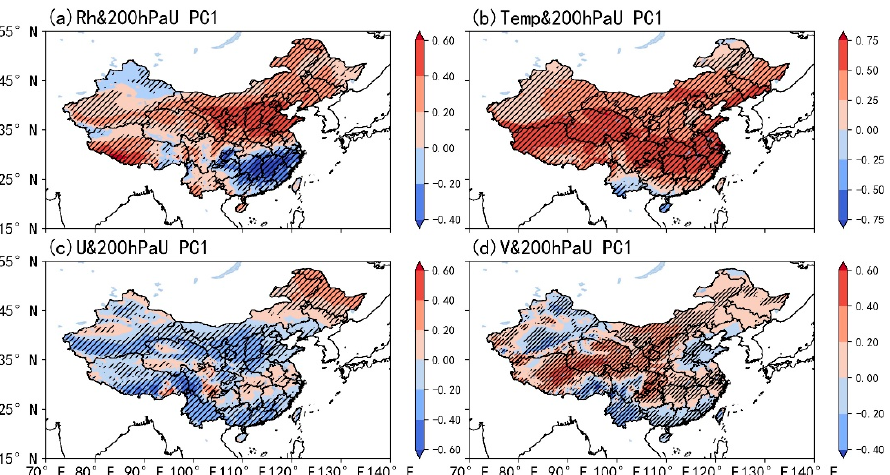
Figure 12. The correlation coefficients between the time series of the EOF1 of the 200 hPa zonal wind and surface meteorological variables of the ( a ) humidity, ( b ) temperature, ( c ) surface zonal wind and ( d ) surface meridional wind in summer during 2013–2018. The slashes indicate that the results passed the 95% Monte Carlo correlation test.